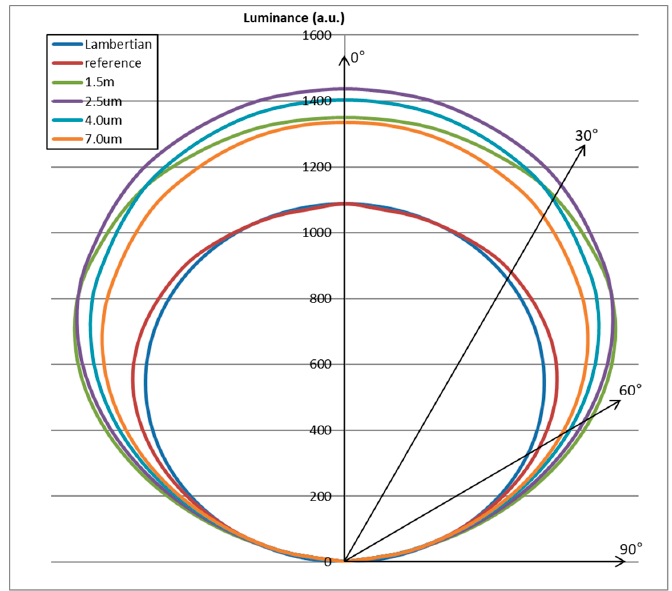
Figure 6. Relative angular luminance distribution of OLED devices with the implemented YSZ nanoparticle scattering layer versus the thickness of scattering layers, compared to the reference device and Lambertian distribution. The Lambertian distribution is plotted using scale-up to the same value of reference device at 0 degree for relative comparision.